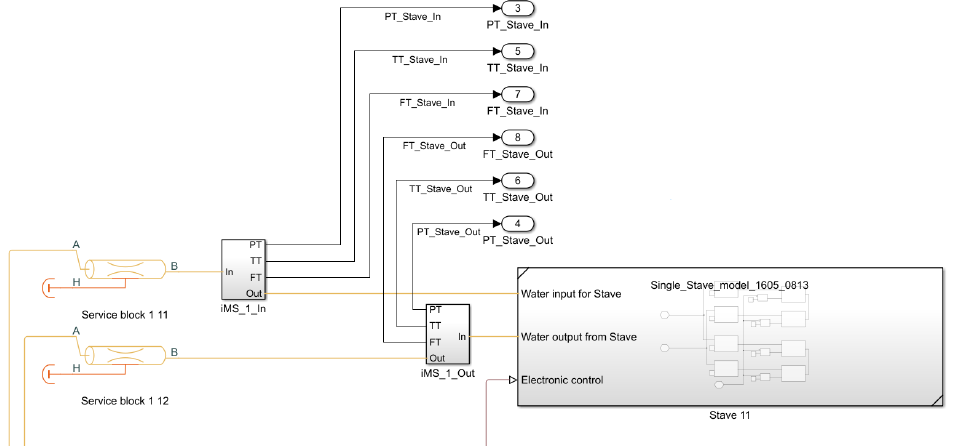
Figure 17. The section internal structure: the measurement